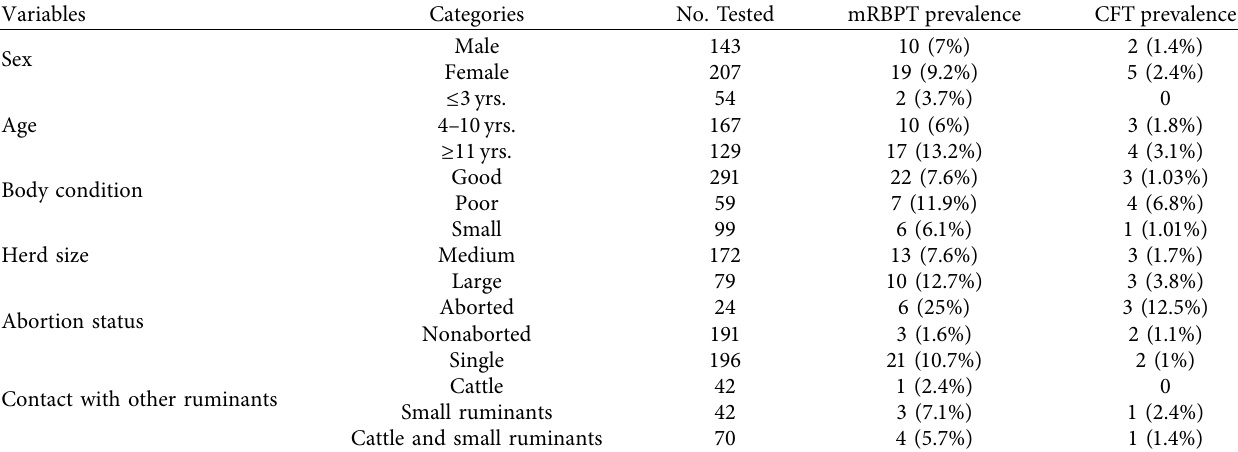
Table 2: Overall seroprevalence of camel brucellosis using mRBPT and CFT tests.